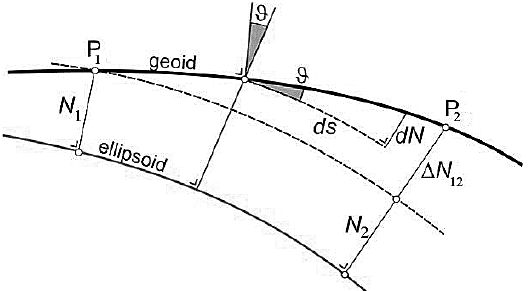
Figure 4. Basic principle of astronomical